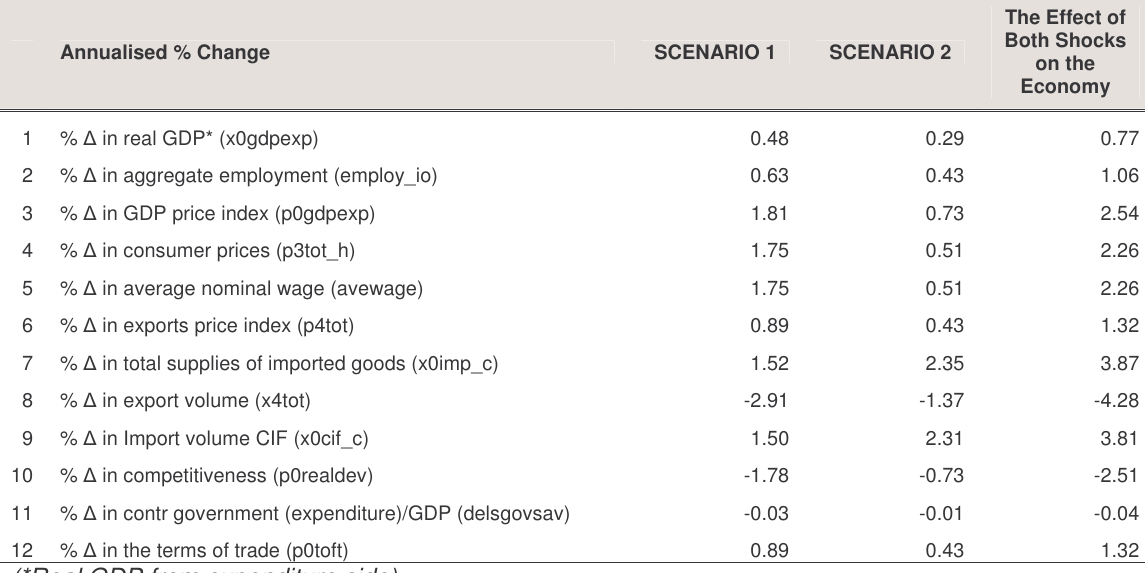
Table 3: Impact on macro-economic variables (% change relative to the base case) Annualised % Change SCENARIO 1 SCENARIO 2